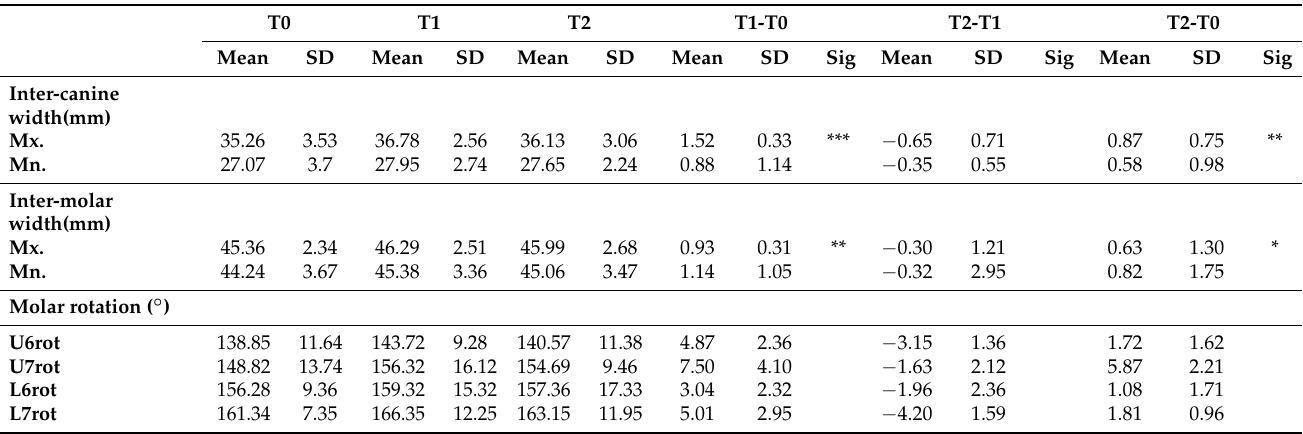
Table 5. Model measurements at pretreatment, post-treatment, postretention, pretreatment to